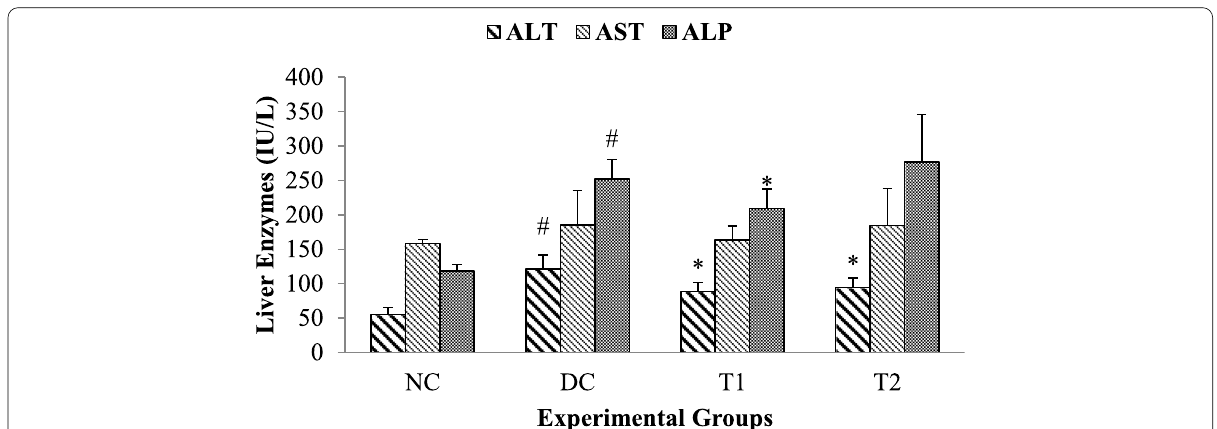
Fig. 3 Effect of probiotic fermented milk products on liver enzymes